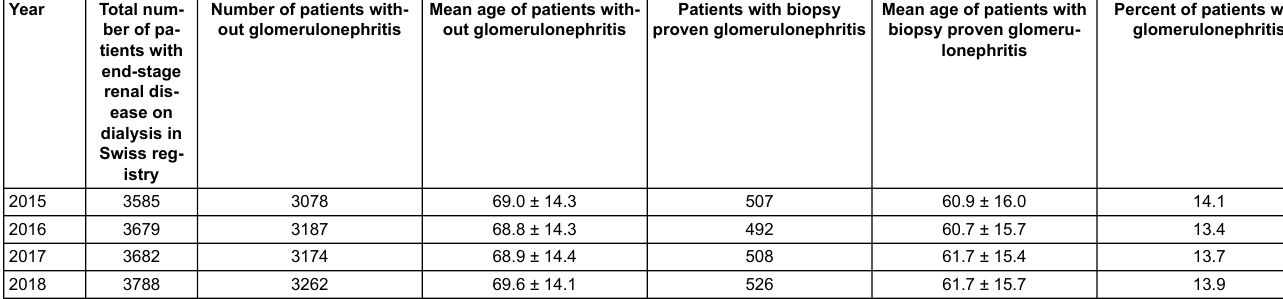
Table 4B: The proportion of incident patients with biopsy-proven glomerulonephritis between 2015 and 2018. Year Total number of incident patients with end-stage renal disease on dialysis in Swiss